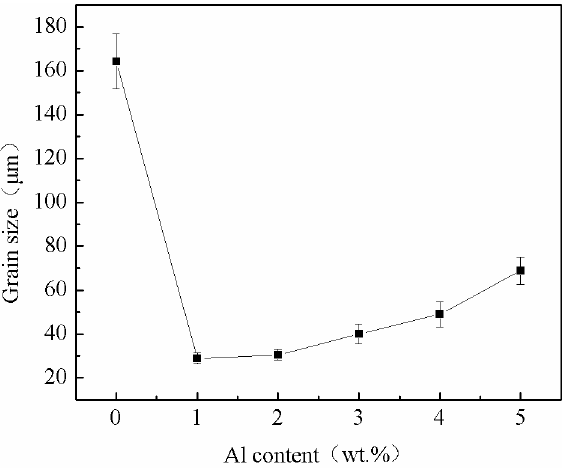
Figure 4. The effect of Al content on the grain size of as-cast Mg-11Gd-2Y-1Zn alloy.